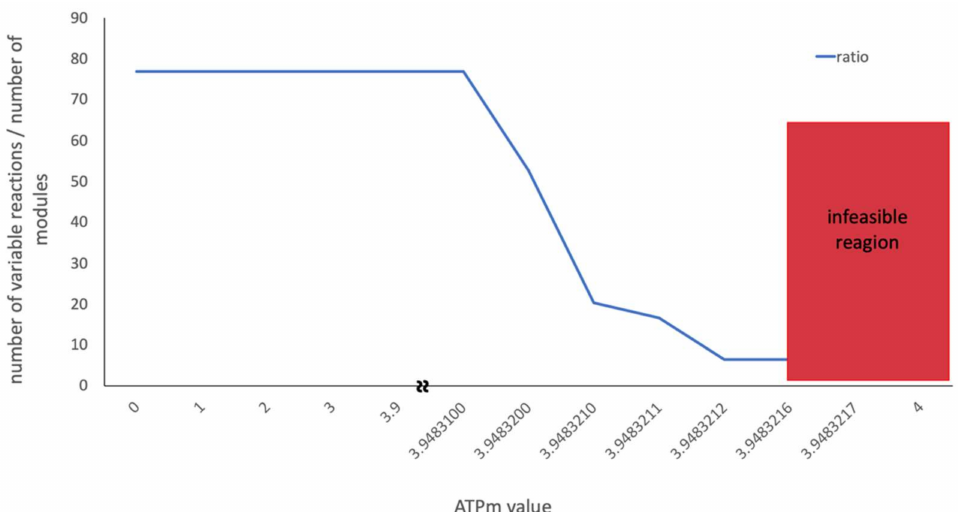
Figure 9. Flux scan of the ATPm value over the feasible region of the wildtype model. The blue line shows the ratio between the number of variable reactions and the number of modules generated by